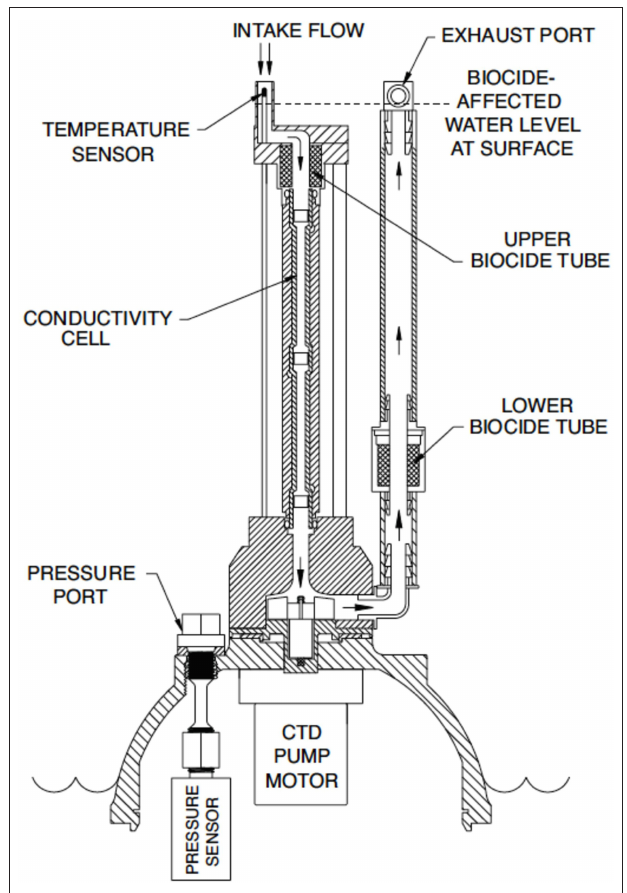
FIGURE 2 | A schematic drawing of a Sea-Bird Scientific CTD unit. [Source: from ( Riser et al., 2018). Copyright 2018 American Geophysical Union (AGU)].